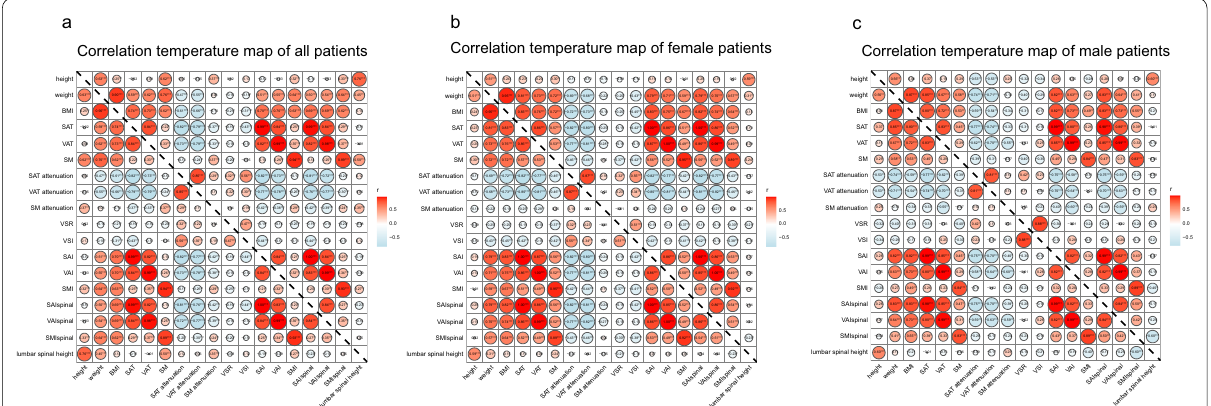
Fig. 2 Correlation temperature map describing correlations between multiple body composition parameters in the 122 study patients. Correlation temperature map of body composition parameters in all patients ( a ), female patients ( b ), and male patients ( c ). BMI body mass index, SM skeletal muscle, SAT subcutaneous adipose tissue, VAT visceral adipose tissue, SMI SM index, SAI SAT index, VAI VAT index, SMI spinal SM area/lumbar spinal height 2 , SAI spinal SAT area/lumbar spinal height 2 , VAI spinal VAT area/lumbar spinal height 2 , VSR area of VAT/area of SAT, VSI area of VAT/(area of VAT area of SAT) +